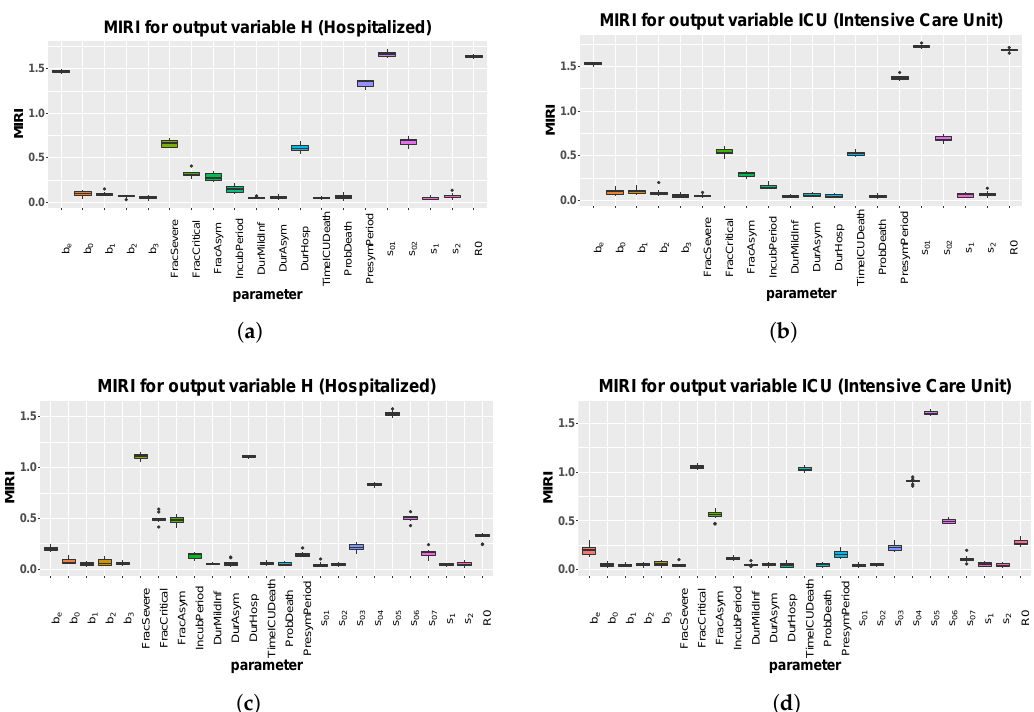
Figure 7. Umbria: boxplot of the 10 realizations of the MIRIs in output from the CRA for all model parameters. ( a ) Evaluation function: area under the curve of H. Stop time: 110. ( b ) Evaluation function: area under the curve of ICU. Stop time: 110. ( c ) Evaluation function: area under the curve of H. Stop time: 250. ( d ) Evaluation function: area under the curve of ICU. Stop time: 250.